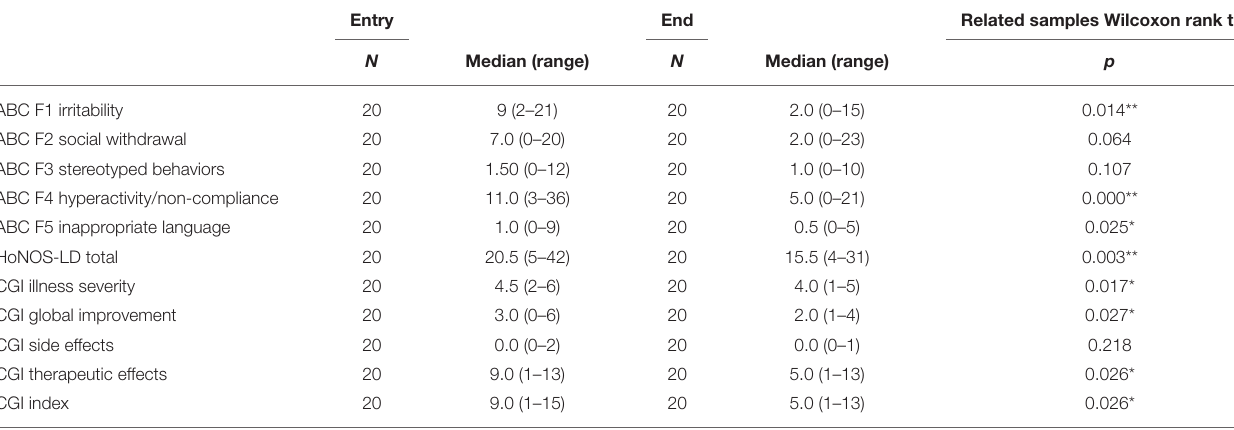
TABLE 4 | Median scores (range) of the ABC scores, HONOS-LD, and CGI at the entry and at the end of the study.